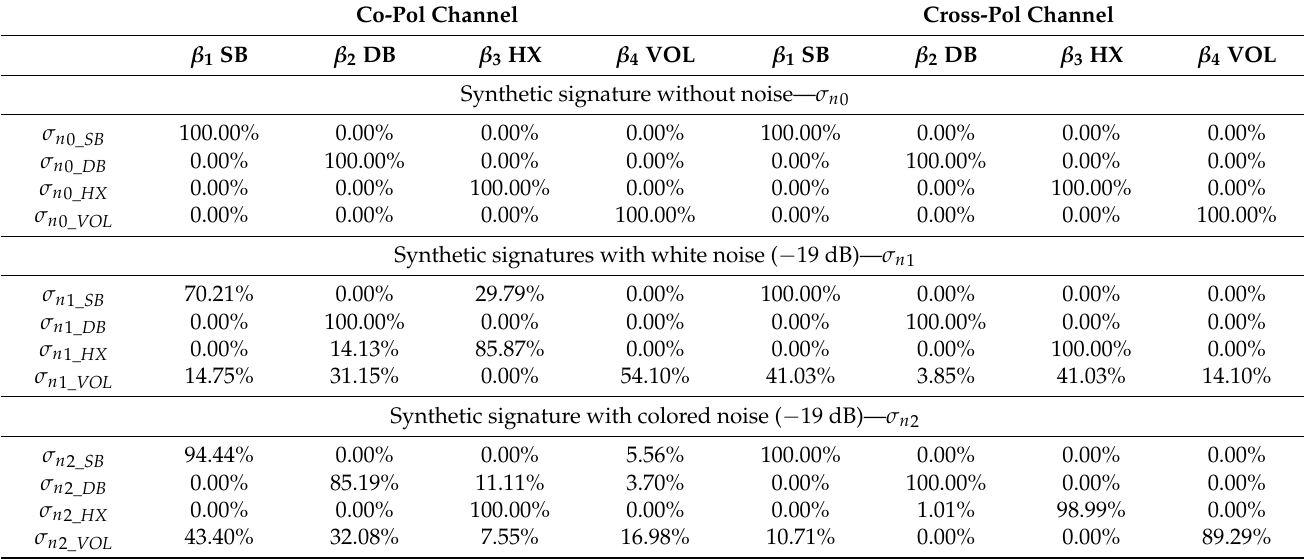
Table 1. Results of SA-based decomposition for synthetic polarimetric signatures (co- and cross- polarized channels). Recognized signatures are specified in